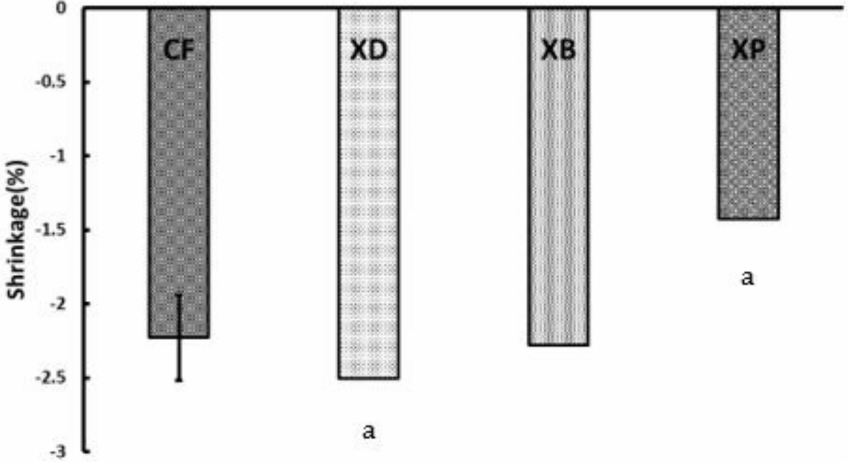
Figure 3. Polymerization shrinkage rate amount when the polymerization shrinkage speed becomes constant of short fiber reinforced composites (0.1 µ m/s or less) (PSC). (Significant difference between the same letters: p < 0.05, I: 95% confidence